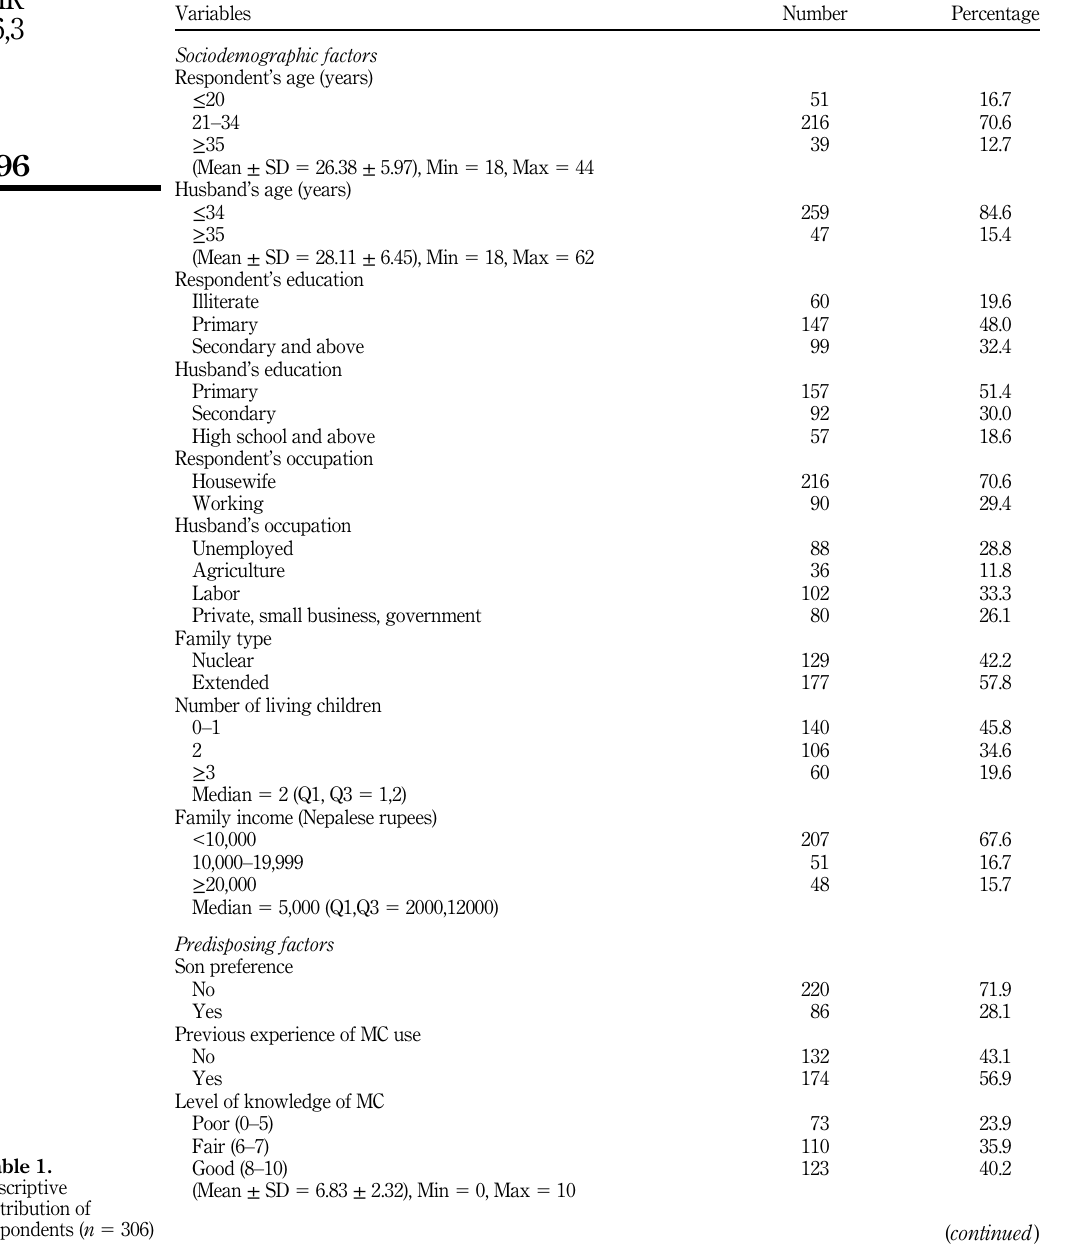
distribution of respondents ( n 5